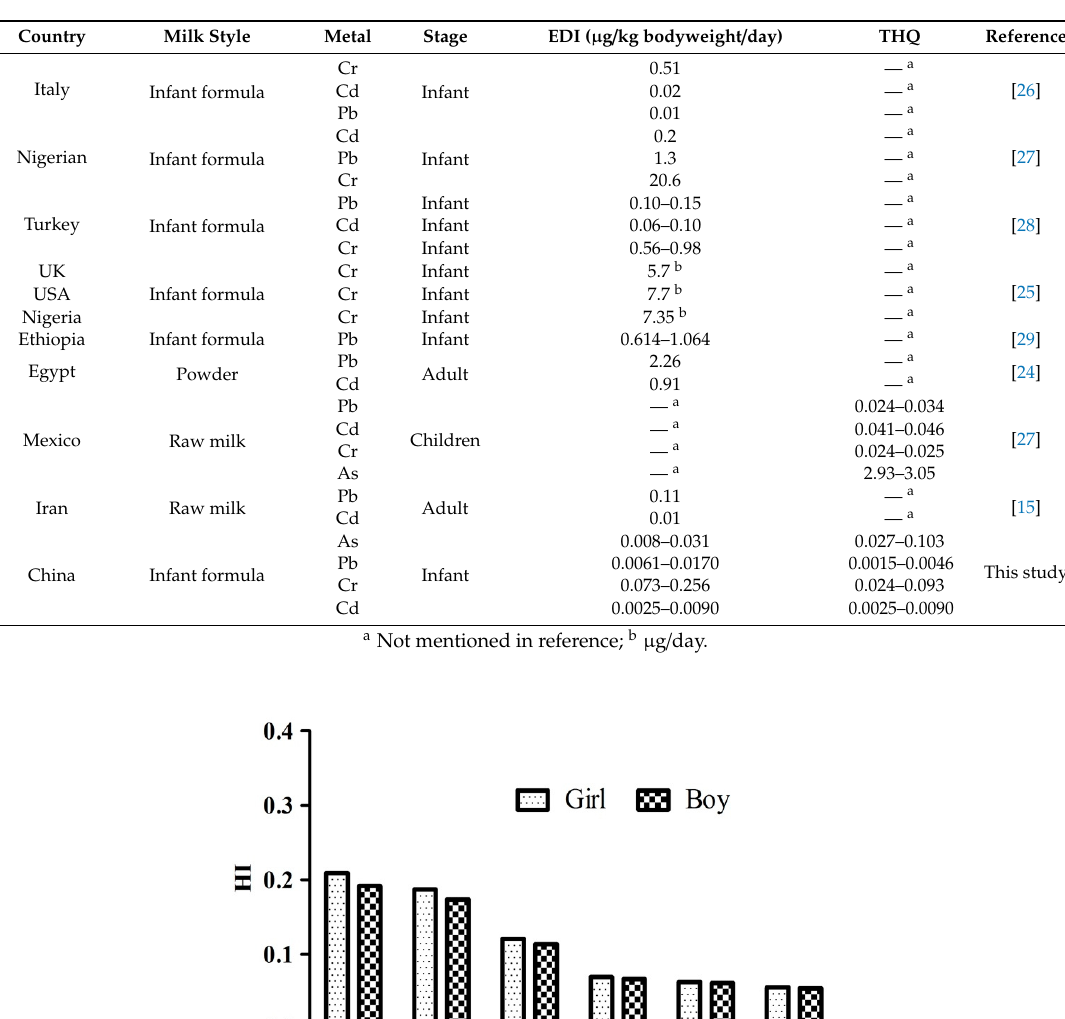
Figure 1. Hazard index (HI) of boys and girls of different age.